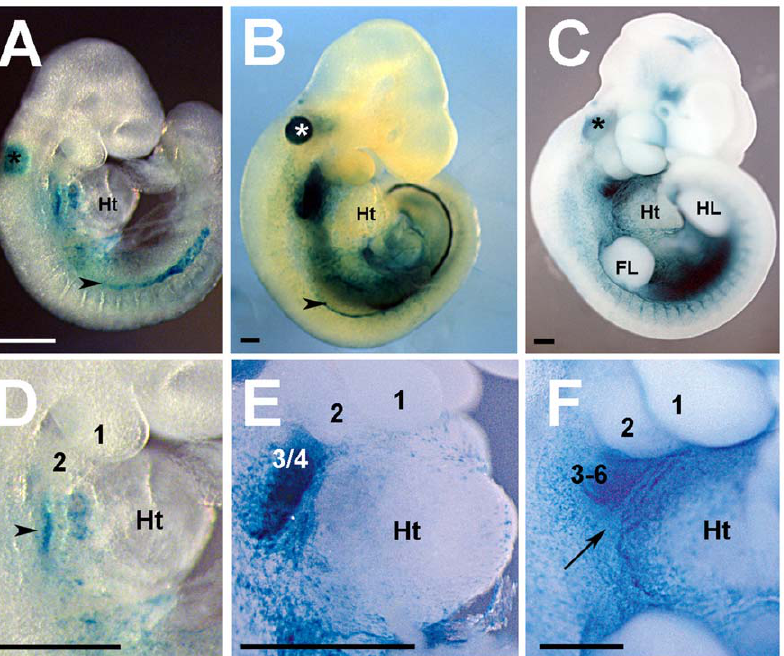
Figure 1. Time course of Hoxa3-lacZ transgene activity at early embryonic stages. (A, B, C) Lateral view of E8.5 (A), E9.5 (B) and E10.5 (C) transgenic embryos stained for lacZ activity and corresponding magnification of the pharyngeal and heart region, (D, E and F, respectively). Arrowheads in A and B indicate the lateral plate mesoderm; the arrowhead in D shows the pharyngeal endoderm; the arrow in F indicates the pharyngeal mesoderm lying caudally to the OFT. Asterisks in A-to-C indicate the otic vesicle. Numbering 1, 2, 3, 4 and 6 indicates the pharyngeal arches. FL; forelimb; Ht, heart; HL, hindlimb. Scale bar=100 m m.